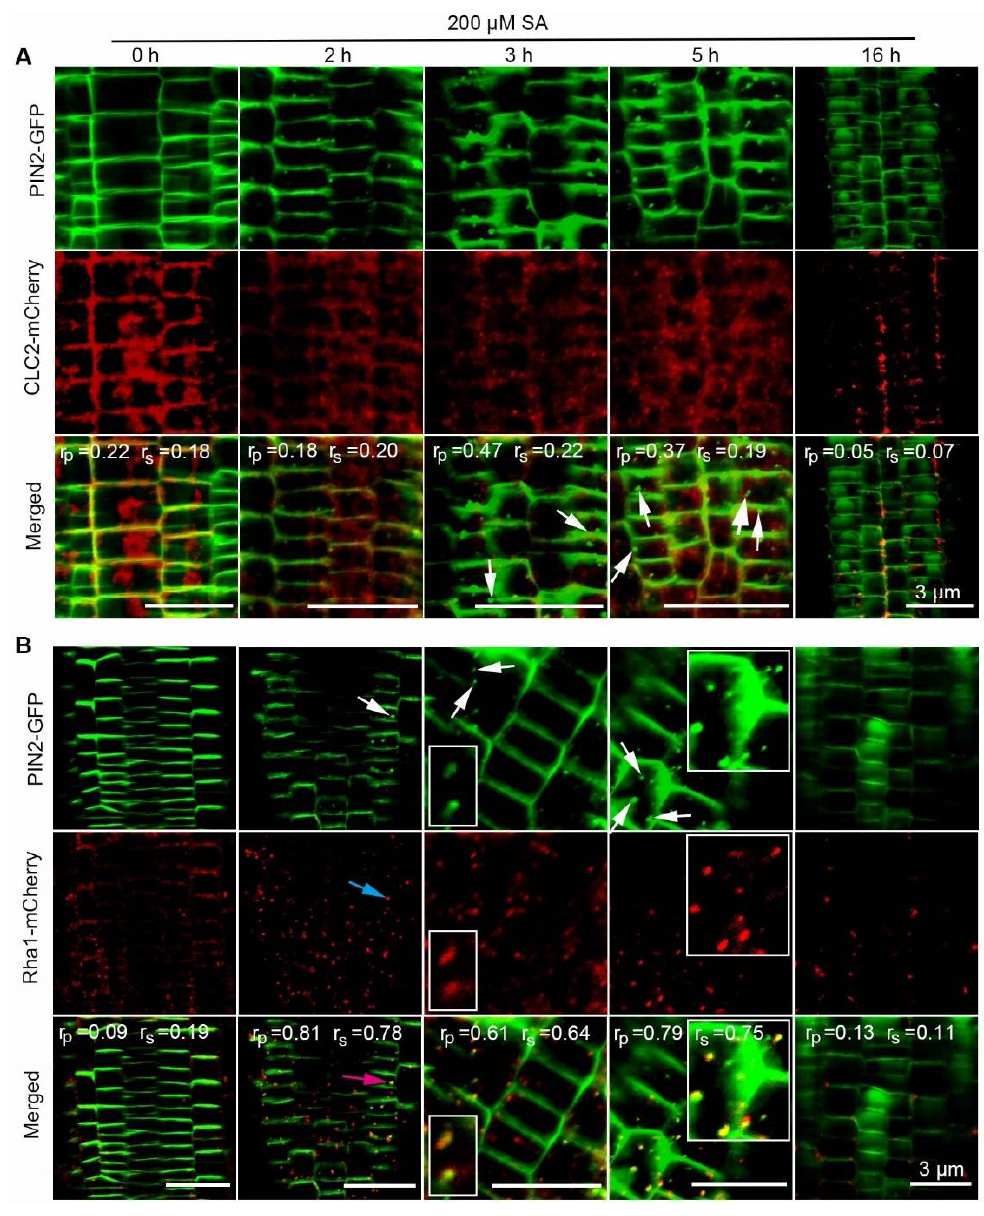
Figure 5. PIN2 is transported to PVC for degradation under a high concentration of SA treatment. Five-day-old transgenic Arabidopsis seedlings harboring both PIN2-GFP and CLC2-mCherry ( A ) or PIN2-GFP and Rha1-mCherry ( B ) were treated with 200 µM SA for 2, 3, 5 and 16 h, respectively. The green, red and yellow fluorescence signals respectively represented GFP, mCherry and the co-localized GFP and mCherry proteins. The white, indigo and red arrows respectively denoted the aggregated PIN2-GFP, Rha1-mcherry, and the co-localized PIN2-GFP and Rha1-mCherry proteins. The small and big white boxes respectively showed the 2× and 8× images of the samples treated for 5 and 3 h. Scale bar = 3 µm. Values of Rp and Rs coefficients were calculated.